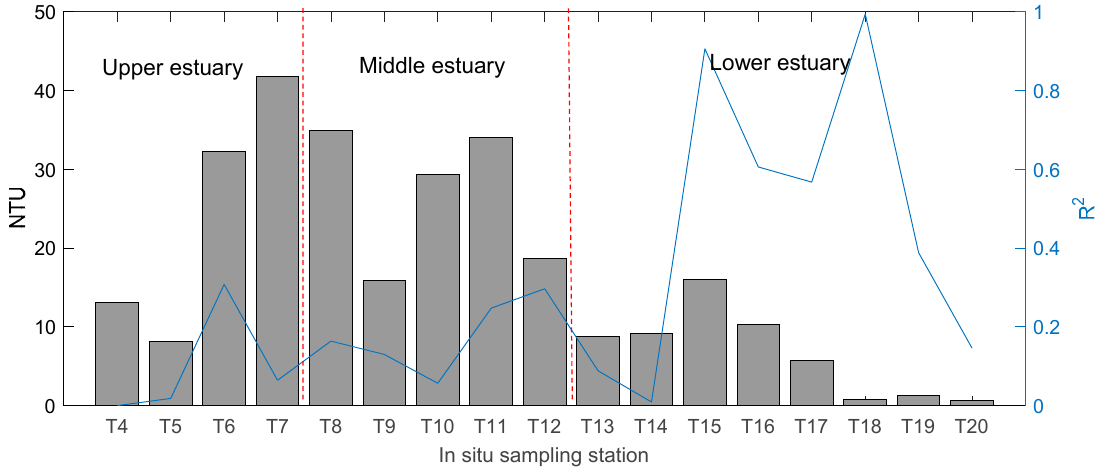
Figure 6. The difference between the average in situ turbidity dataset and the turbidity estimated with a model based on the turbidity vs. surface reflectance relationship (left y-axis). The relationship ( r 2 ) between in situ turbidity and Band 1 surface reflectance, based on matchups from a combination of images ( n = 114) that had the highest correlation with in situ values (right y-axis).